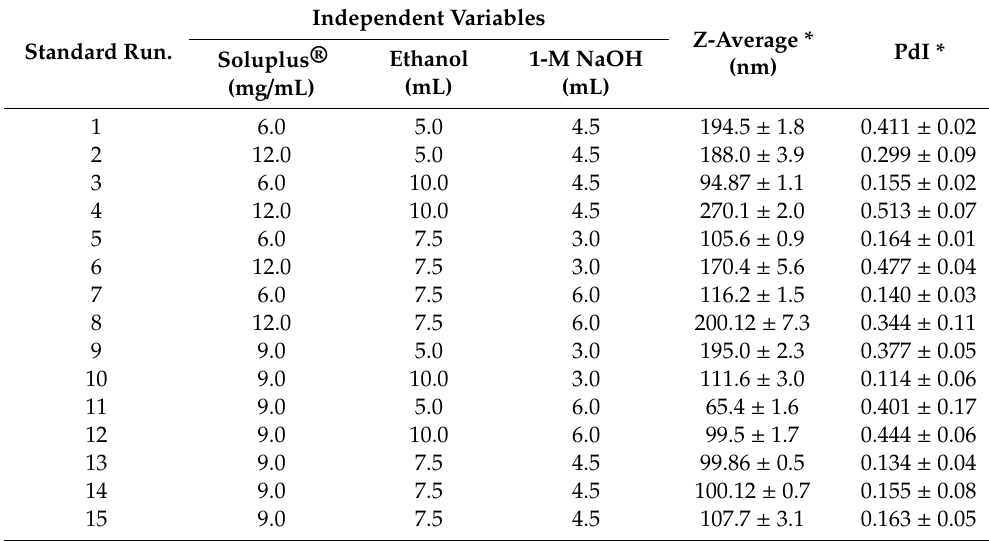
Table 2. Composition and responses of the Box–Behnken factorial design.